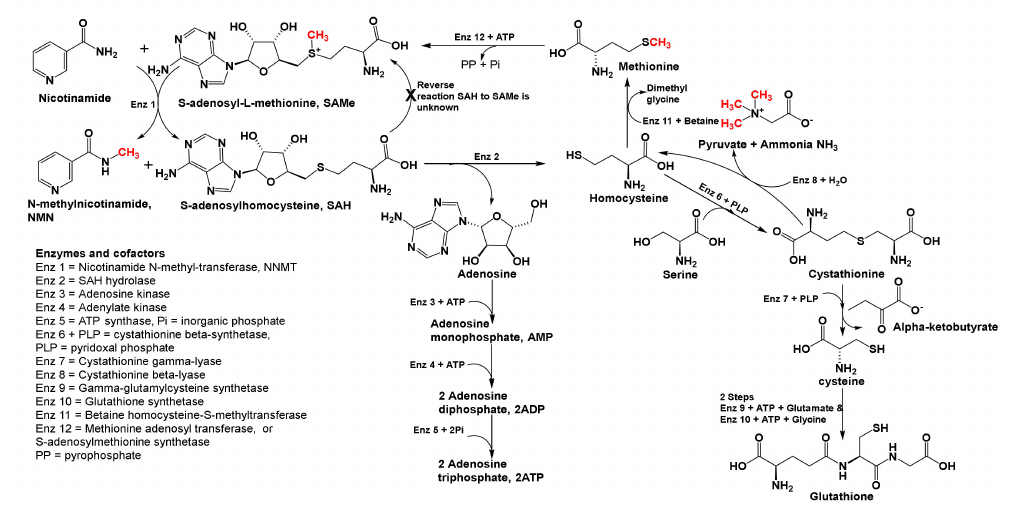
Figure 5. Methyl transfer by SAMe, B 12 , or betaine; syntheses of ATP, cystathionine, cysteine and glutathione; and regeneration of SAMe. Methyl and other alkyl group transferases take the name of the substrate they methylate or alkylate; for example, nicotinamide- N -methyl transferase, NNMT methylates nicotinamide, as shown here. All methyl groups in transfer reactions herein are shown in bold red font. SAMe and NNMT convert nicotinamide to NMN and SAH. However, SAH does not directly revert to SAM; instead, SAH is hydrolyzed to adenosine and homocysteine. Either a molecule of SAMe, vitamin B 12 , or betaine can convert homocysteine to methionine, which then reforms SAMe. Upon formation, adenosine is eventually converted to ATP, and homocysteine to cystathionine that transulfurates with serine to form cysteine, and then glutathione